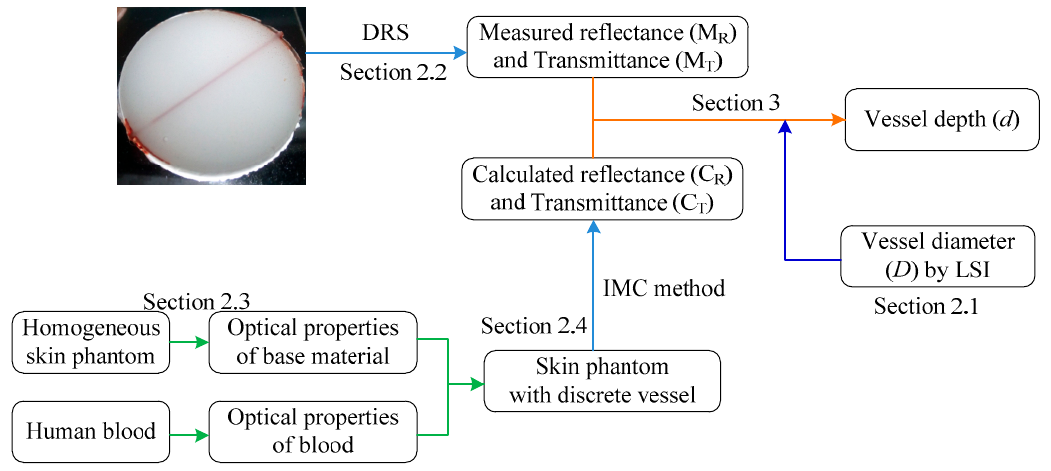
Figure 11. Extraction of vessel depth via the DRS-based inverse method in the PWS tissue model.